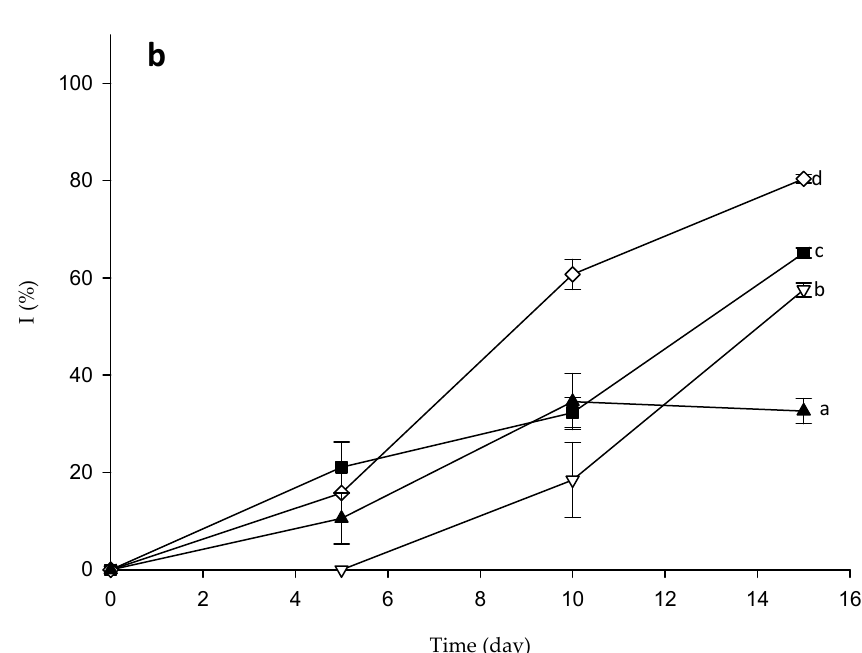
Figure 6. Fungal ( a ) and mesophilic aerobic bacterial ( b ) inhibitions on the epicarp of pitayas during storage at 10 °C and relative humidity (RH) of 80 % for control and coated fruits (See Table 2 for treatment identification). Data are the mean and their standard deviation ( n = 3). Different letters among traces mean significant differences ( p < 0.05).